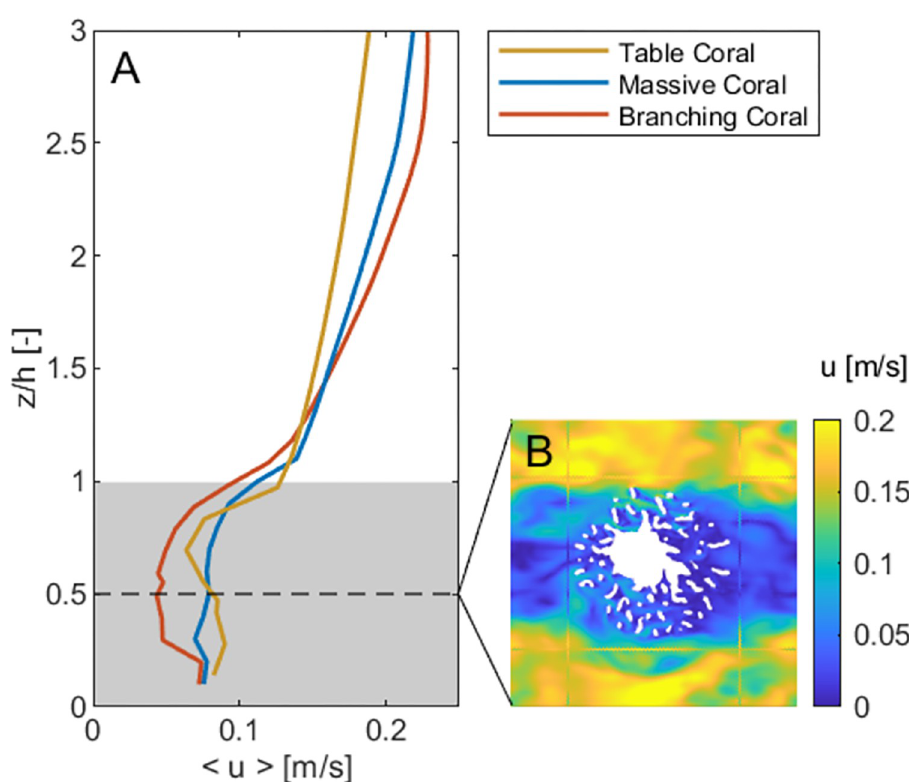
Fig 4. (A) Vertical profiles of the temporally- and horizontally-averaged velocity ( < u > ) for the archetypal coral forms. The shading represents the vertical region used to calculate the depth-averaged in-reef velocity ( U significant horizontal variability (at z/h = 0.5) of the instantaneous flow field within a reef consisting of the branched